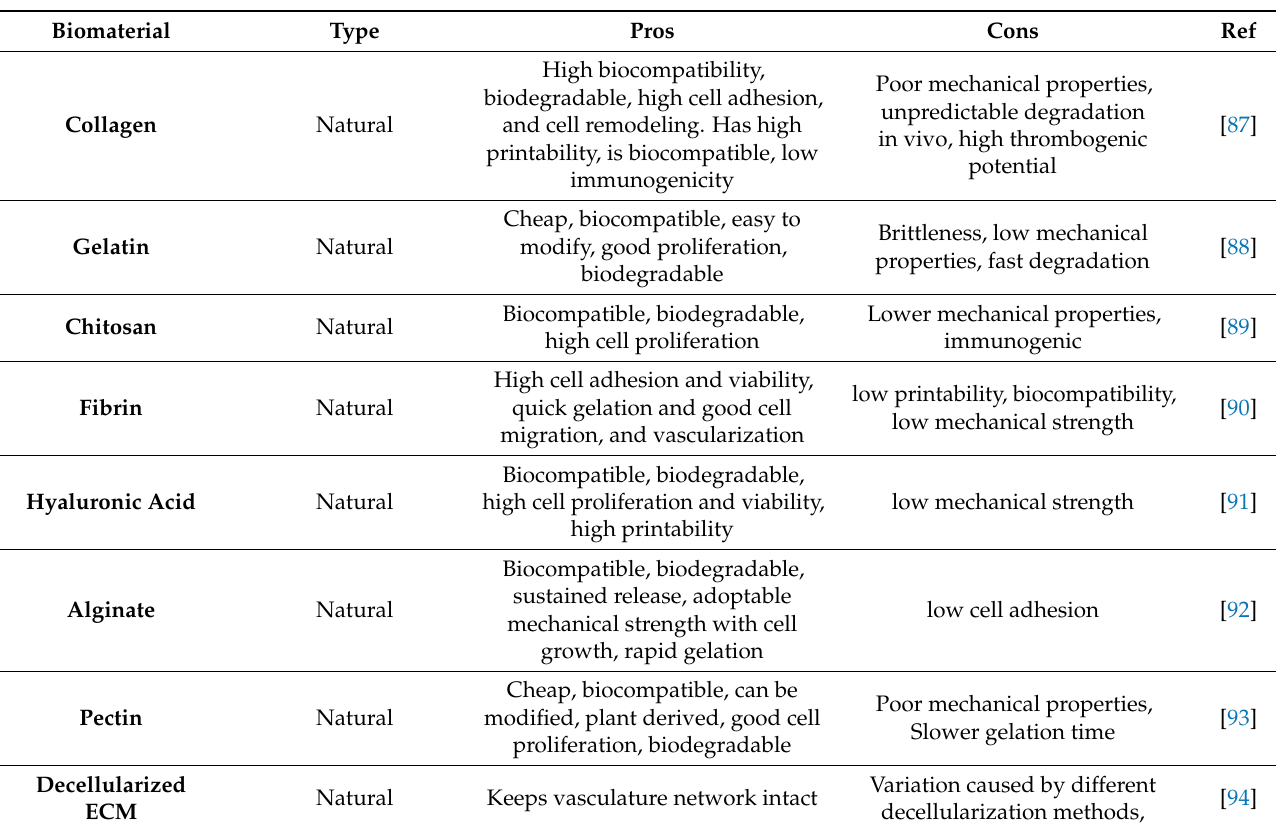
Table 3. List of Biomaterials, both natural and synthetic employed in tissue engineering and their advantages and